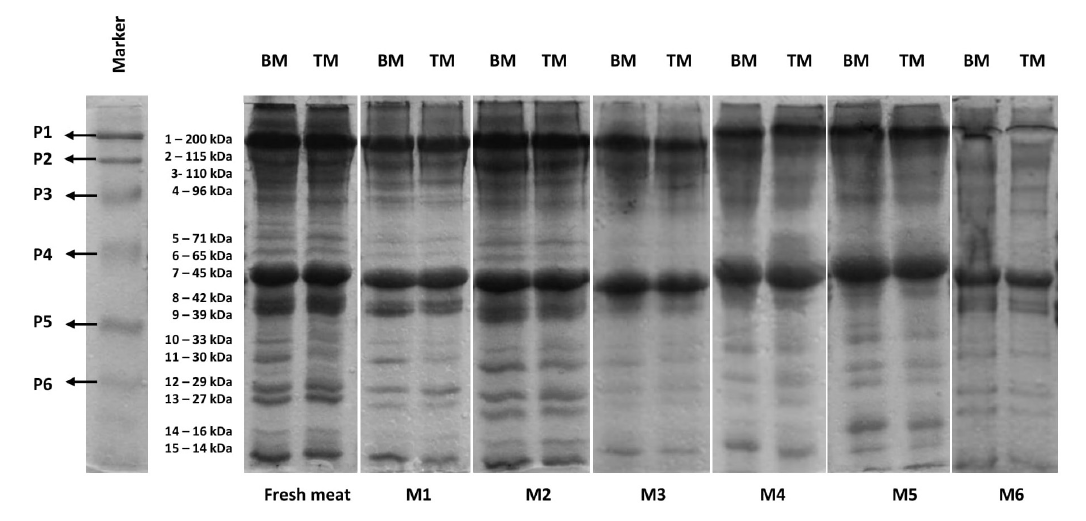
Fig. 2. Myofibrillar protein pattern of chicken breast and thigh meat during 6 months of frozen storage (BM = chicken breast meat; TM = chicken thigh meat; FM = fresh meat; M1 = 1-month-old frozen sample; M2 = 2-month- old frozen sample; M3 = 3-month-old frozen sample; M4 = 4-month-old frozen sample; M5 = 5-month-old frozen sample; M6 = 6-month-old frozen sample; P1 = myosin (202.82 kDa); P2 = β-galactosidase (115.56 kDa); P3 = bovine serum albumin (98.22 kDa); P4 = ovalbumin (51.37 kDa); P5 = carbonic anhydrase (37.24 kDa); P6 = soybean trypsin inhibitor (29.00 kDa); P7 = lysozyme (19.75 kDa); P8 = aprotinin (6.66